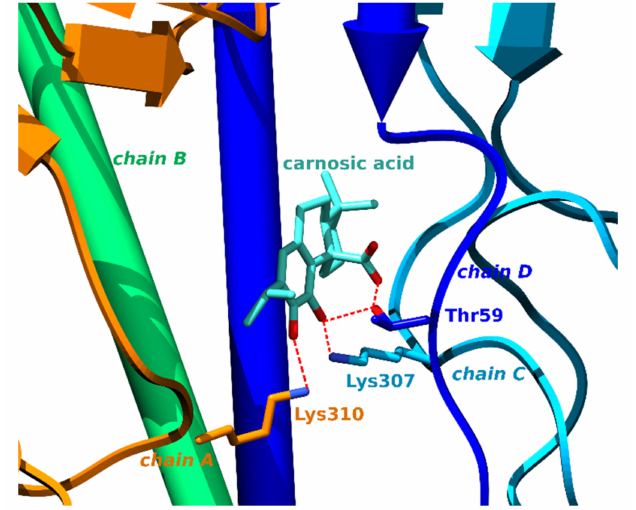
Figure 4. Carnosic acid glues together chains A, C and D of the HA glycoprotein. Carbons of carnosic acid are displayed as teal sticks, chain A in orange, chain B in green, chain C in sky blue and chain D in dark blue pipes and planks. Amino acids forming hydrogen bonds (denoted with red dotted lines) are displayed as sticks of matching